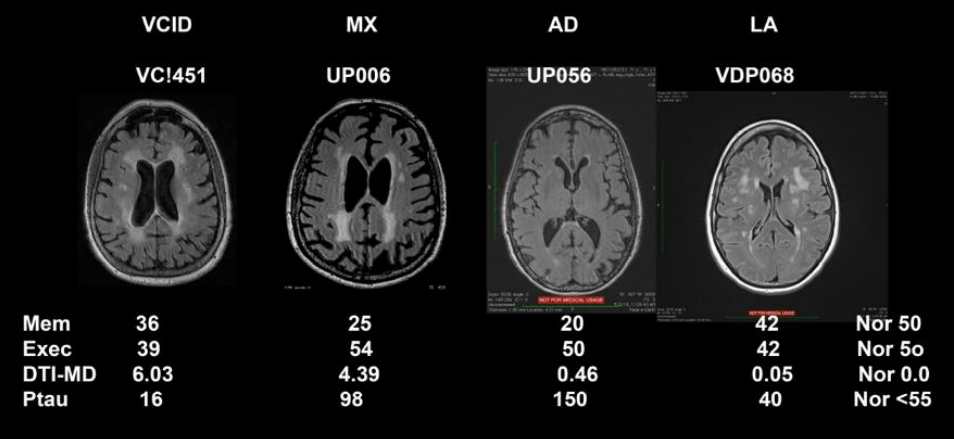
Figure 1. MRI fluid attenuated inversion recovery (FLAIR) sequences on top and biomarker values for each of the patients from the di ff erent diagnostic categories. The vascular cognitive impairment and dementia (VCID) patient has a normal memory and executive score. The di ff usion tensor imaging-mean di ff usion (DTI-MD) is elevated with a normal of 0.0 since these are z-scores, and the Ptau is normal. The mixed dementia (MX) patient shows a low memory and normal executive function, an elevated DTI-MD, and an increased Ptau. The Alzheimer’s disease (AD) patient has very low memory score with a normal executive function, a normal DTI-MD and an extremely elevated Ptau. The leukoaraiosis (LA) patient has white matter changes on FLAIR, but normal scores for all the biomarkers, including MD. Normal (Nor) values are shown in the right column. Using biomarkers for patient stratification into SIVD, MX, AD, and LA, di ff erences between diagnostic categories becomes evident. This can be seen in data shown in Table 3. The MX patients tended to have higher values than other groups in most areas. The age of the patients with dual pathologies is higher than in other groups. T-scores for executive function are lowest in the SIVD group due to the damage to white matter, but executive function scores are not able to separate patients well. Memory function, on the other hand, is more clearly delineated with the lowest scores seen in the AD patients, and also in MX. The other neuropsychological tests failed to provide clear separation of the patients. Table 3. Major features in the di ff erent patient groups separated by the biological biomarkers.